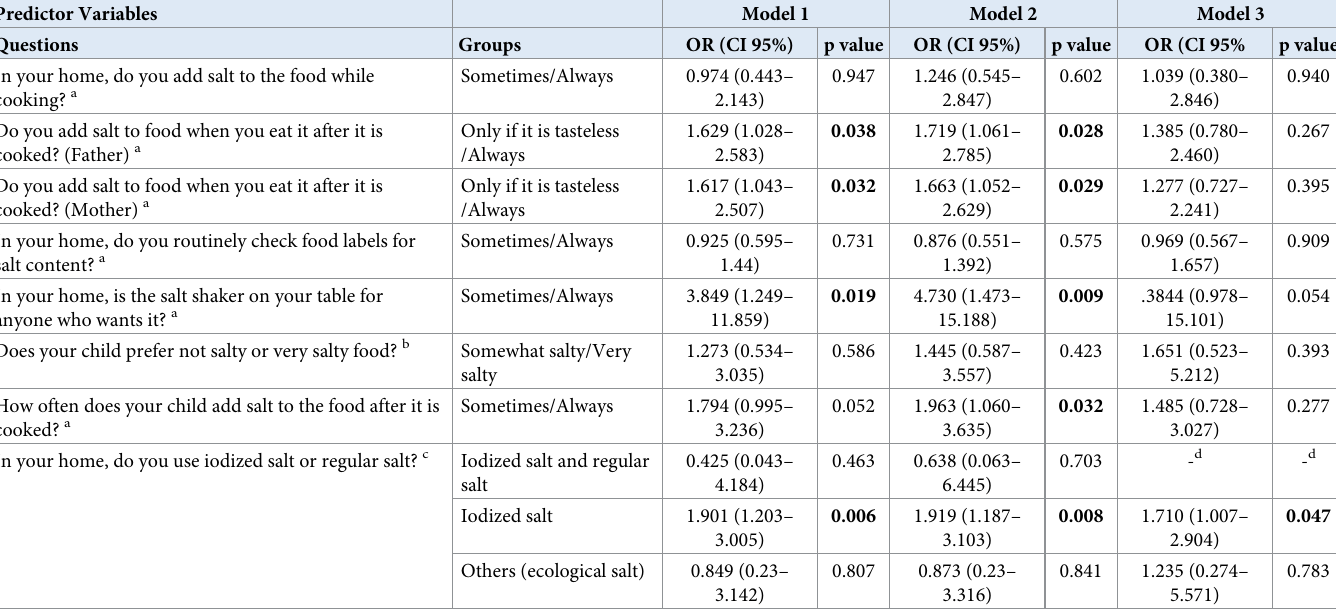
Table 3. Logistic regression models. Odds ratios and 95% confidence intervals for the presence of sodium excretion greater than 3048 mg/day (50th